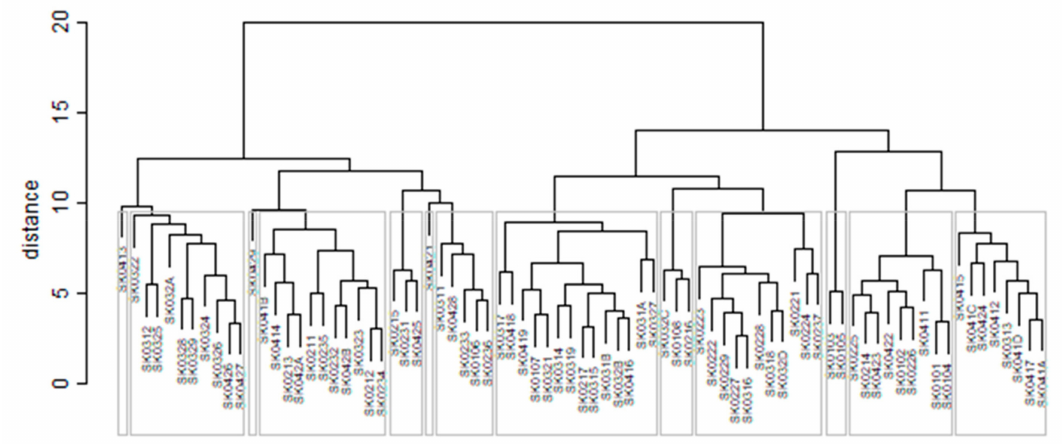
Figure 26. Preventable mortality dendrogram of the districts for the male sex in the whole explored period. Source: own elaboration by the authors.